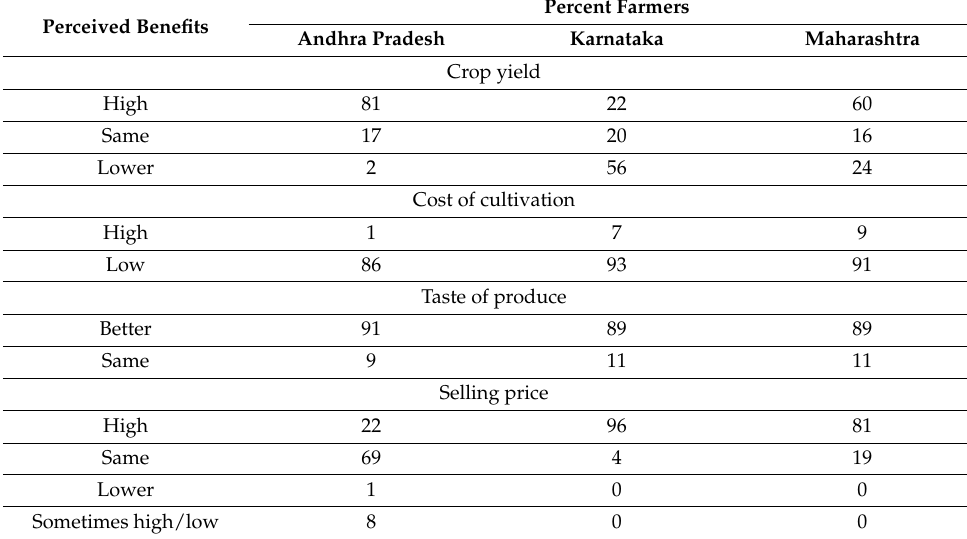
Table 4. Benefits perceived by Natural Farming